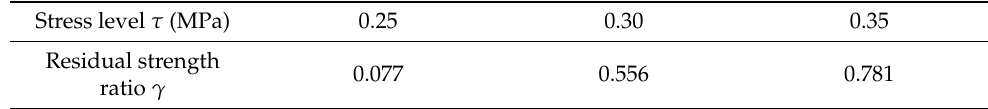
Table 8. Residual strength ratio of new CL under different stress